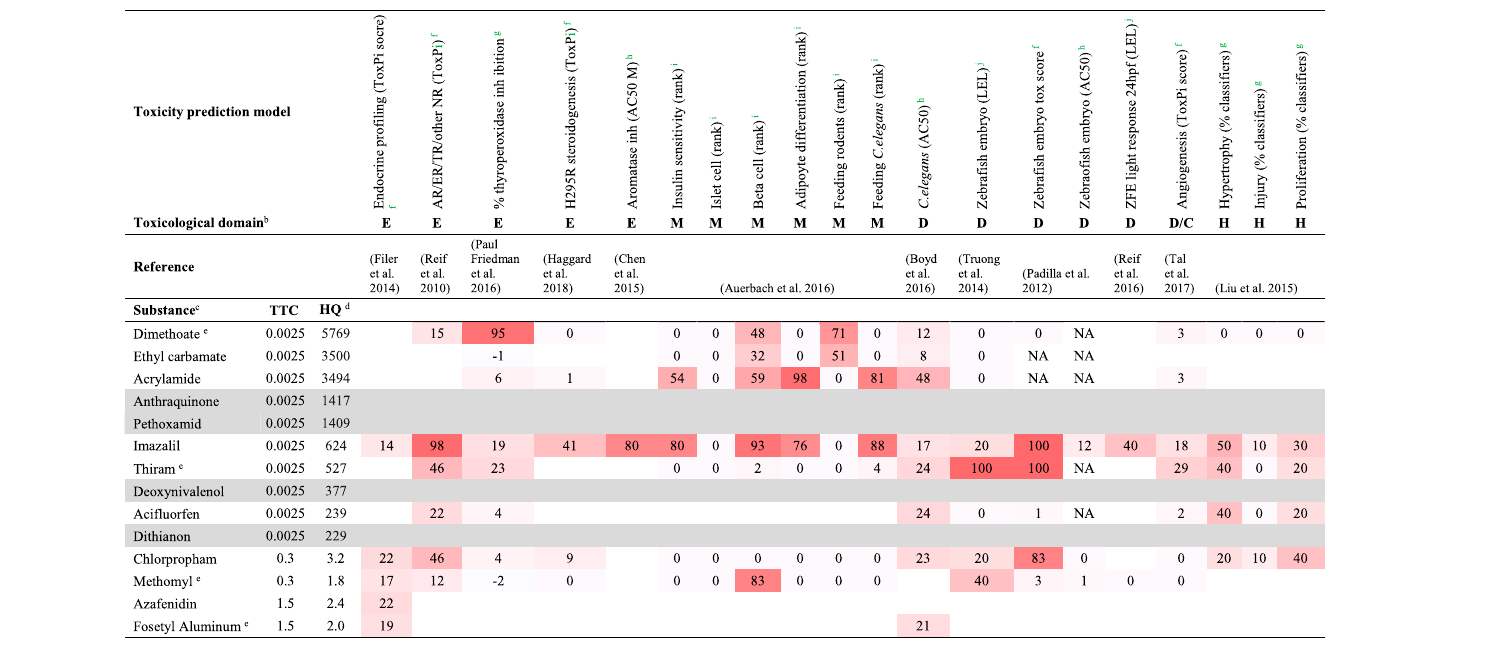
TABLE 2 HTS results for substances with highest Hazard Quotients within each TTC class a